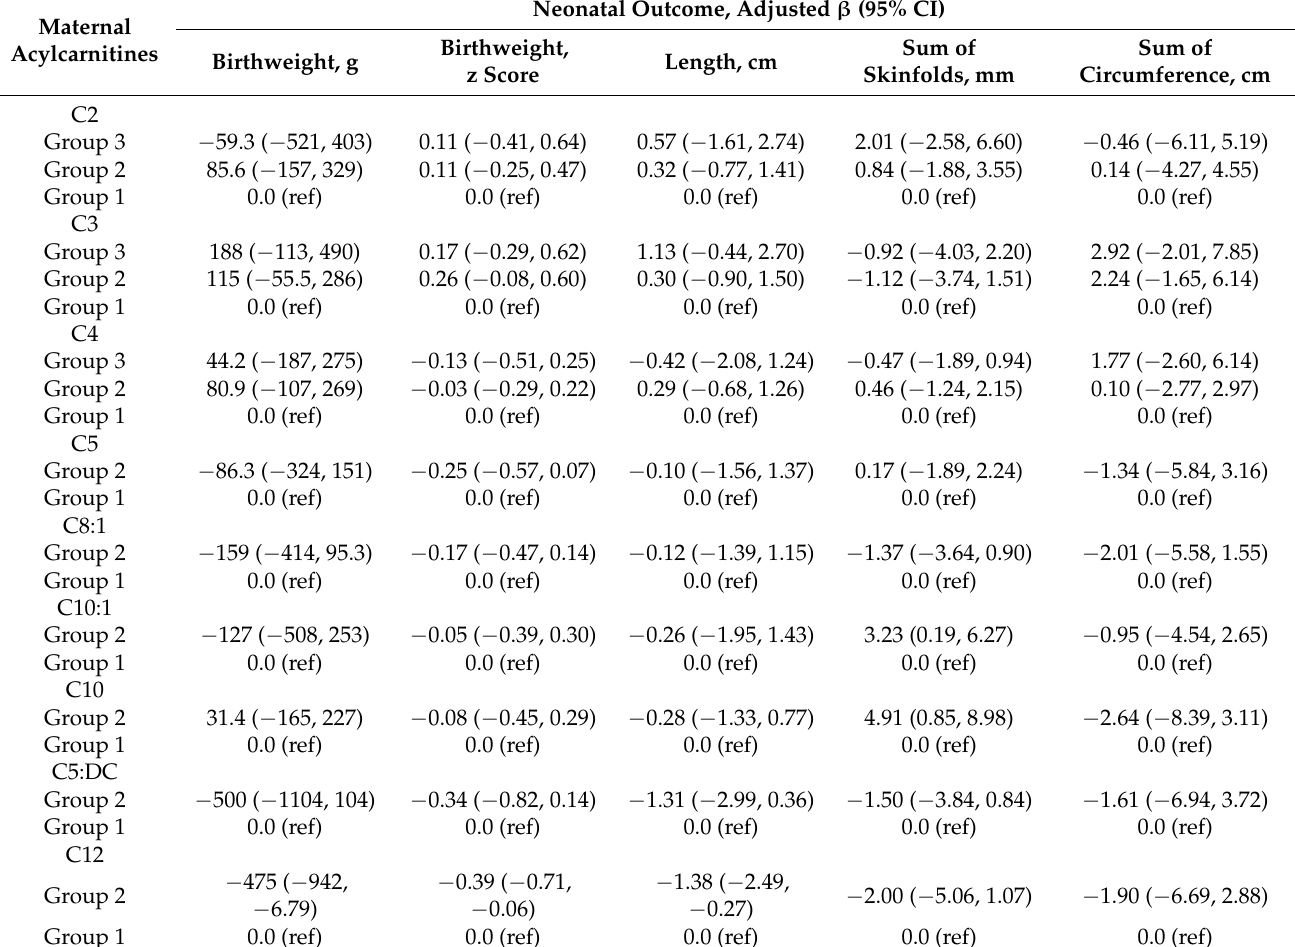
Table 2. Acylcarnitine trajectories across gestation and the association with neonatal birthweight, birthweight z score, length, sum of skinfolds, and sum of circumstances a,b